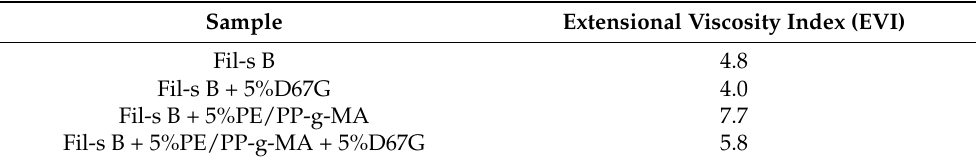
Table 5. EVI values for Fil-s B-based